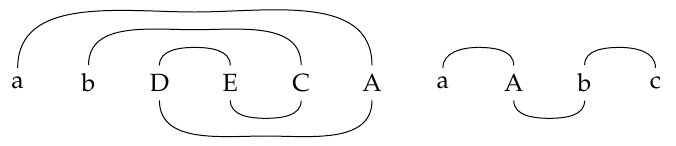
Figure 1. Marking corresponding to a derivation of abac